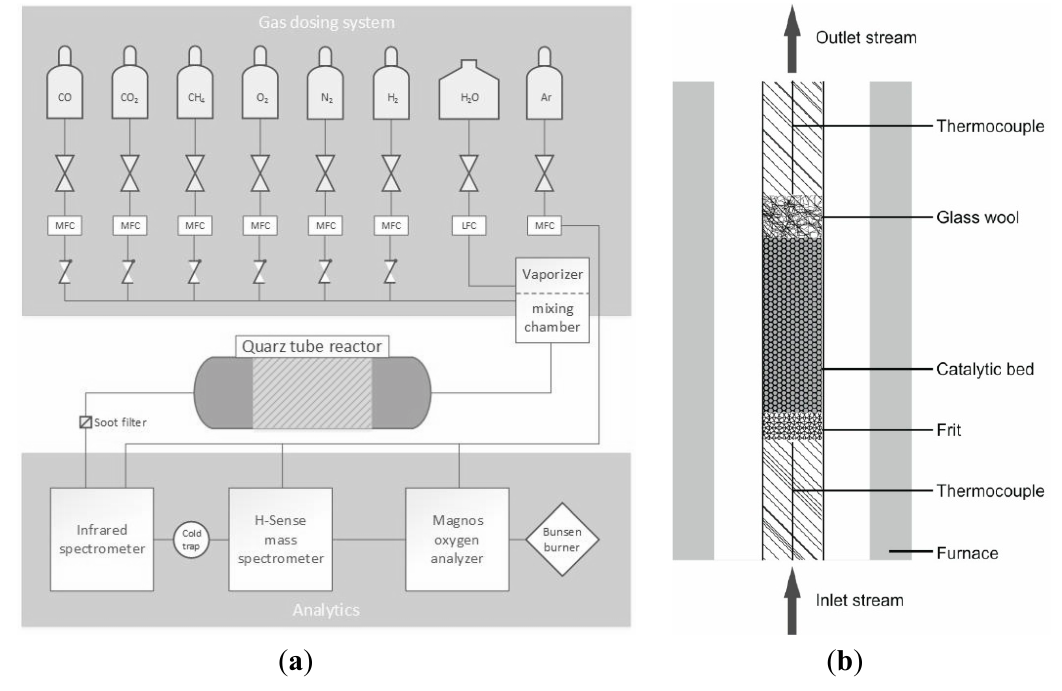
Figure 1. Schematic diagram of the experimental setup used for catalytic oxidation and reforming experiments over a nickel bed catalyst ( a ) and schematic drawing of the packed bed reactor ( b